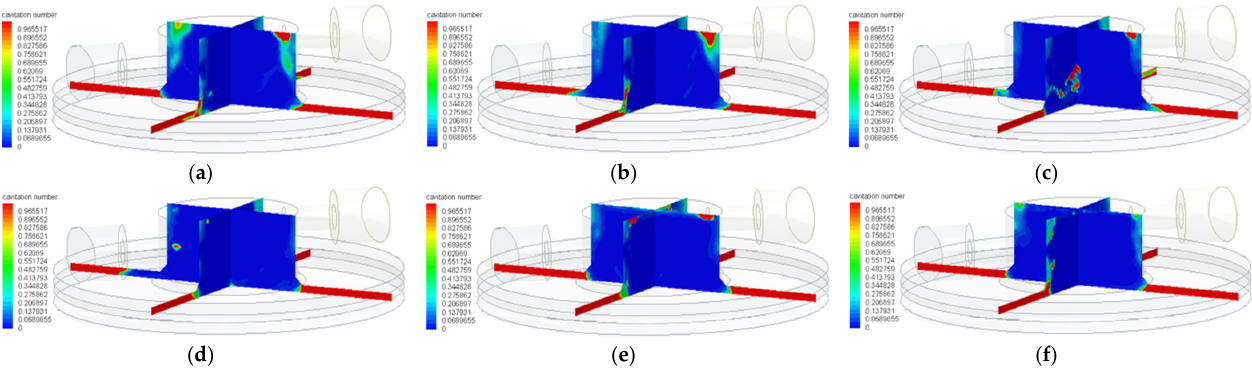
Figure 25. When inlet pressure = 15 MPa, gap = 1.5 mm, the variation of pressure of suction cup- θ 20 with time in adhesion interface plane at: ( a ) 5 ms, ( b ) 9.4 ms, ( c ) 13.8 ms, ( d ) 18.2 ms, ( e ) 22.6 ms, and ( f ) 27 ms.